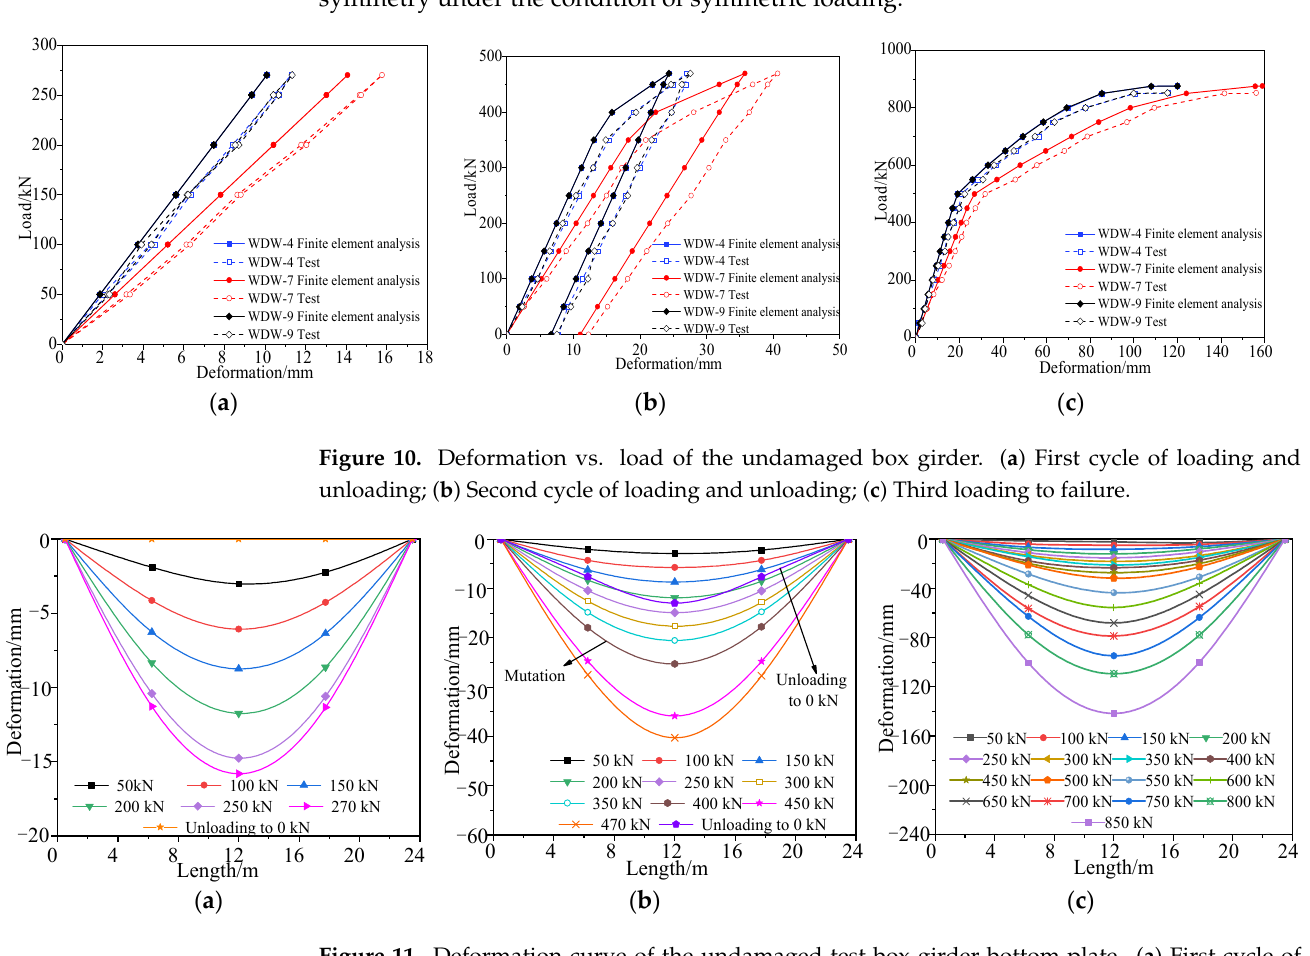
( c ) Figure 12. Strain vs. load curve of the concrete web at midspan of the undamaged test box girder. ( a ) Elastic stage; ( b ) Working stage with cracks; ( c ) The failure stage.